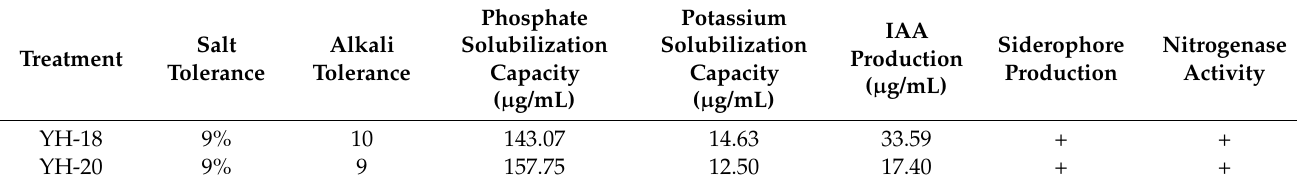
Table 4. Growth promoting characteristics of YH-18 and